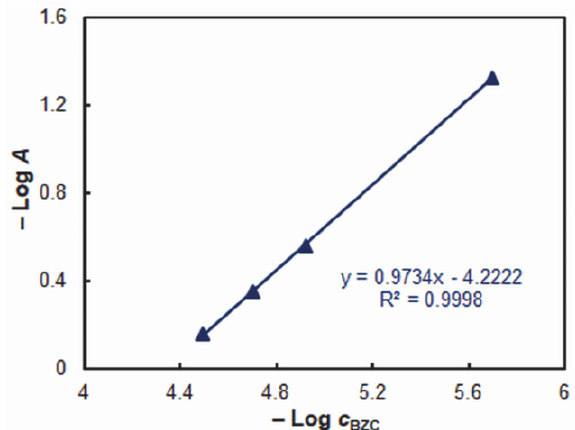
Figure 6. Determination of the BZC-to-Co molar ratio by the Bent- French limited logarithm method.